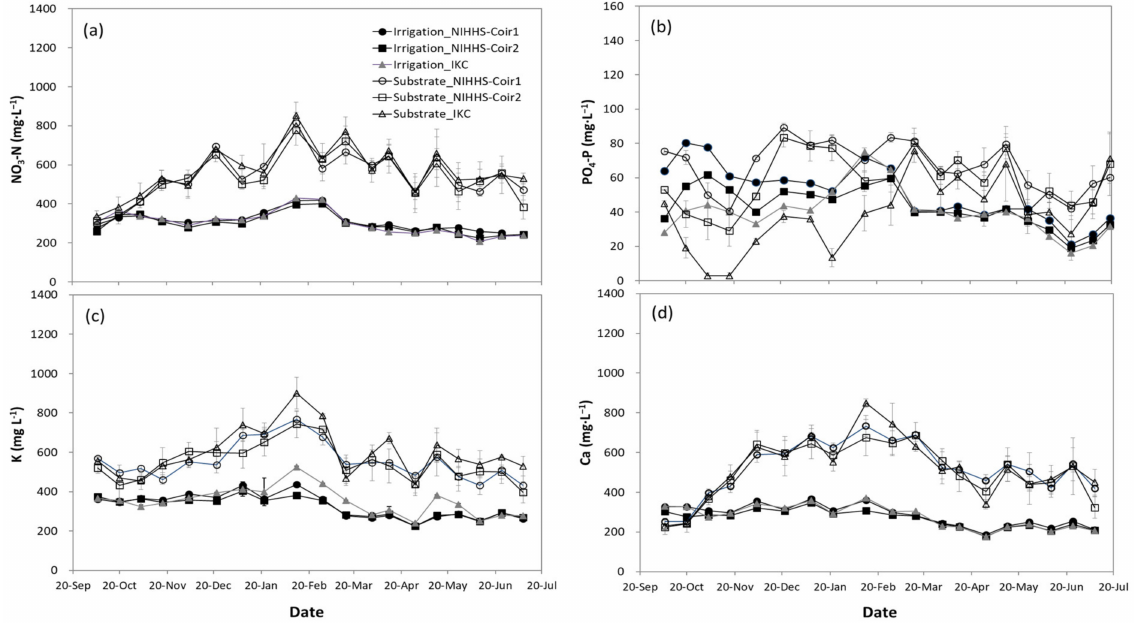
Figure 6. Changes in NO 3 -N ( a ), PO 4 -P ( b ), K ( c ), and Ca ( d ) in the irrigation and RZ of each nutrient solution (NIHHS-Coir1, NIHHS-Coir2, and IKC) in the closed hydroponic system with a coir substrate. Vertical bars indicate standard errors of the means ( n =